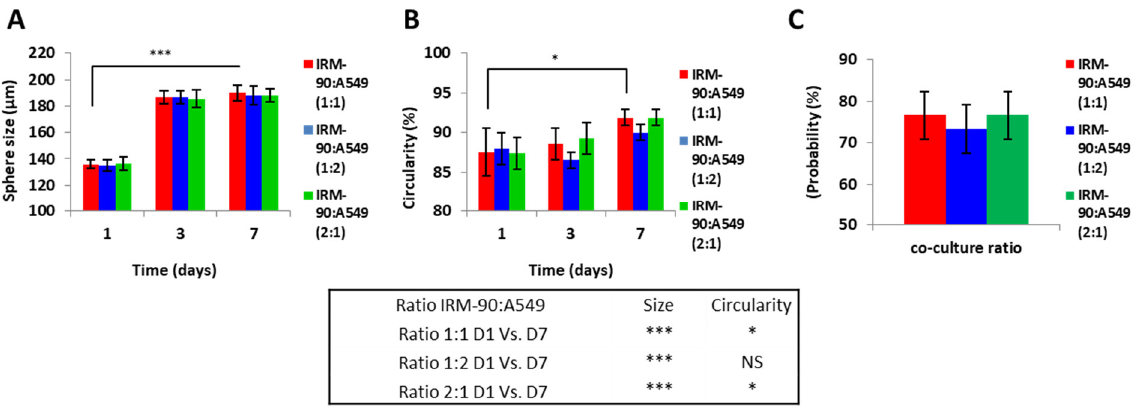
Figure 6. MCTSs were produced from different ratios of tumor (A549) and stromal (IRM-90) cells. ( A ) Spheroid size on days 1, 3, and 7 of culture. In all three ratios between tumor and stromal cells, the size of the spheroids significantly changed on day 7 when compared to day 1 (D1 vs. D7 *** p < 0.0001). However, spheroids from different ratios of tumor–stromal cells (1:1, 1:2 and 2:1) on day 7 did not have a statistically significant difference in size. ( B ) Circularity of spheroids for the stromal–tumor ratio of IRM-90:A549 1:1 and IRM-90:A549 2:1 was increased significantly on day 7 when compared to day 1 (D1 vs, D7 * p < 0.05) and for IRM-90:A549 1:2 was not statistically significant (non-significant = NS). However, spheroids from different ratios of tumor–stromal cells (1:1, 1:2, and 2:1) on day 7 did not have a statistically significant difference in terms of circularity. ( C ) Probability of spheroid formation on-chip. By changing the ratio of tumor and stromal cell probability, spheroid production did not change statistically significantly. The total number of cells is 1 × 10 6 cells/mL for all three ratios. p < 0.05 is considered statistically significant. All assays were performed as triplicates per trial in three independent experiments. (Error bars represent ± SE, n = 3).